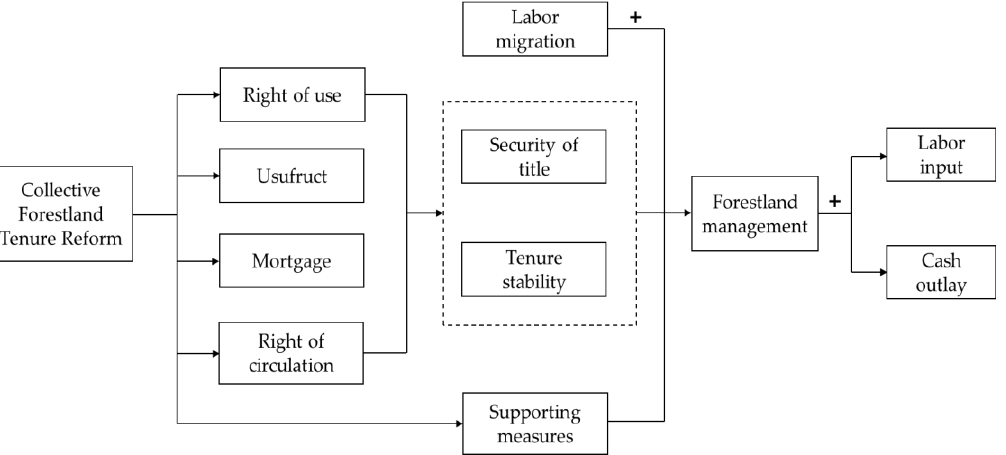
Figure 1. The impact mechanism of Collective Forestland Tenure Reform on rural households’ inputs. Note: + implies a positive direction of impacts in